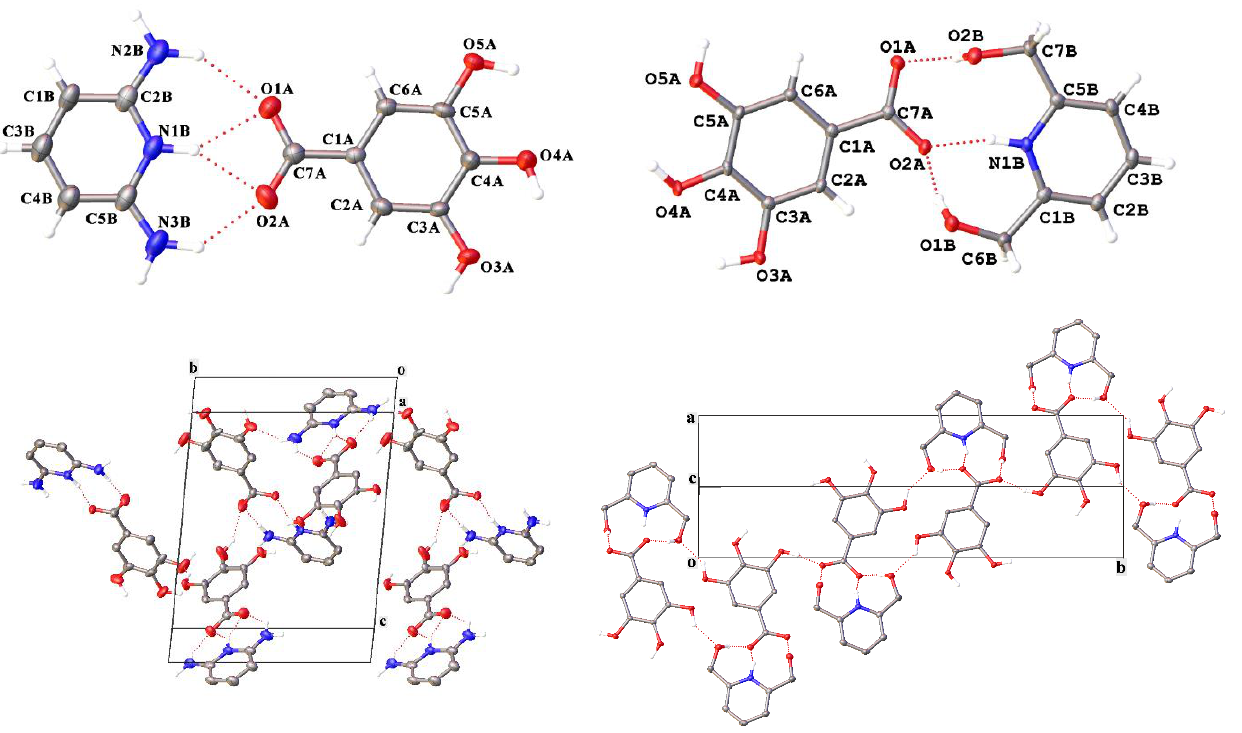
Figure 3. General views of 4 ( top left ) and 5 ( top right ) with second symmetry-independent species of 4 and a disordered molecule of acetonitrile omitted for clarity and fragments of the crystal packing in 4 ( bottom left ) and 5 ( bottom right ) illustrating the formation of hydrogen-bonded interpenetrating network and double layers, respectively. For the general view of the second symmetry-independent formula unit of 4 , see Figure S1 of Supplementary